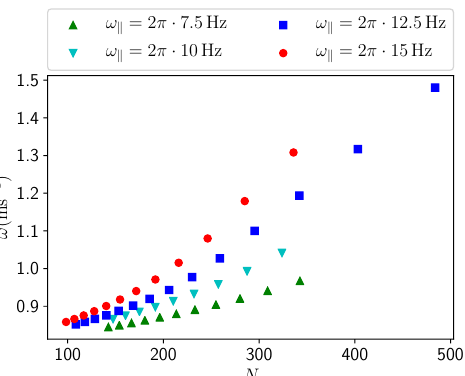
Figure 12: Frequencies ω of density-phase oscillations at the center of the trap as a function of the number of particles in the gas, N . The frequencies are extracted from a fit with Eq. (67). The temperature of the initial state is